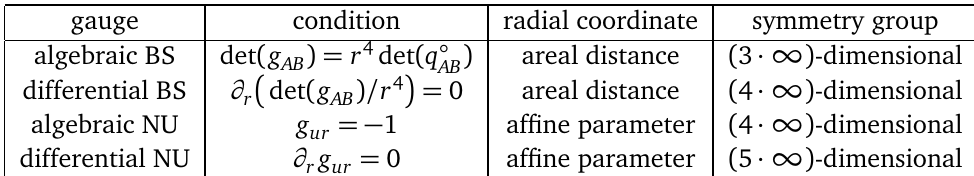
Table 1: Summary of the different time-dependent symmetry parameters which appear in the various gauges. In the algebraic BS gauge the asymptotic symmetry group contains one supertranslation and two superrotations. In the differential BS gauge this is extended to include a Weyl rescaling. In the algebraic NU gauge however we have an extra radial trans- lation only, while the use of the differential NU gauge also allows for Weyl transformations, and therefore leads to a 5-dimensional symmetry algebra given by